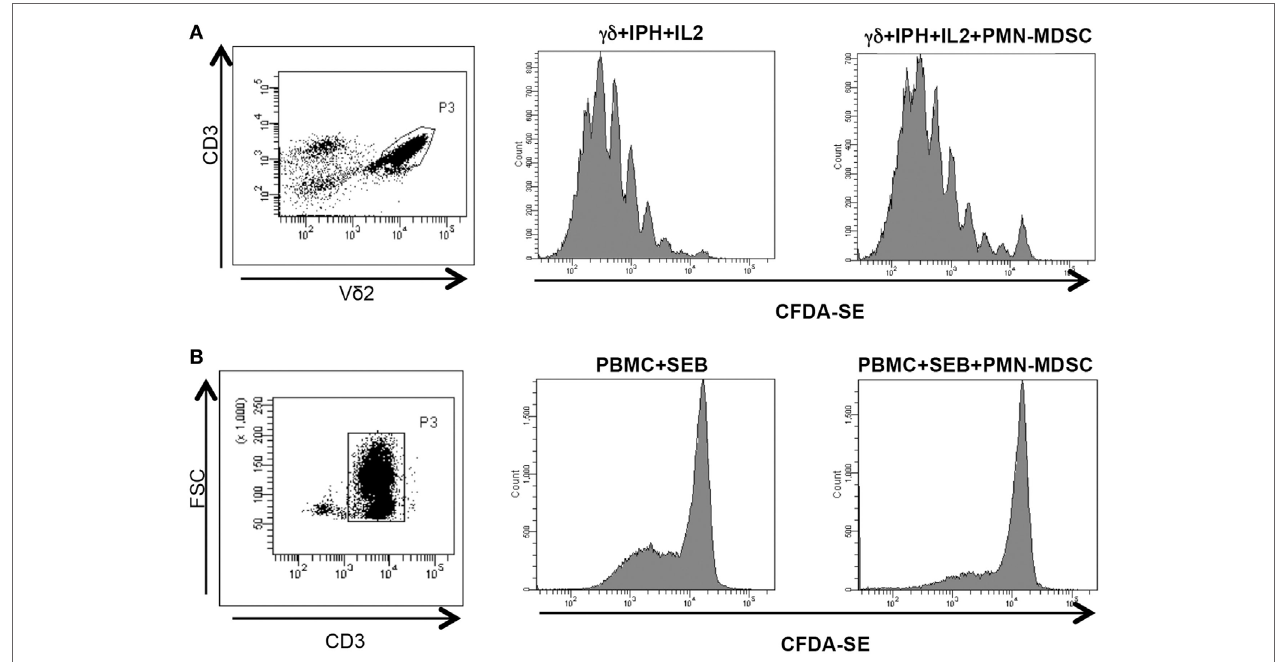
FigUre 3 | PMN-myeloid-derived suppressor cells (MDSC) does not inhibit V δ 2 T cell proliferation. γδ T cells or peripheral blood mononuclear cell (PBMC) labeled with CFDA-SE were stimulated with IPH in the presence of PMN-MDSC (1:1 ratio). After 5 days, V δ 2 + and CD3 + T cells proliferation was evaluated by flow cytometry. Representative gating strategy and histogram plots of one out of three independent experiments showing V δ 2 T cells (a) and CD3 + T cells (B) proliferation in the indicated